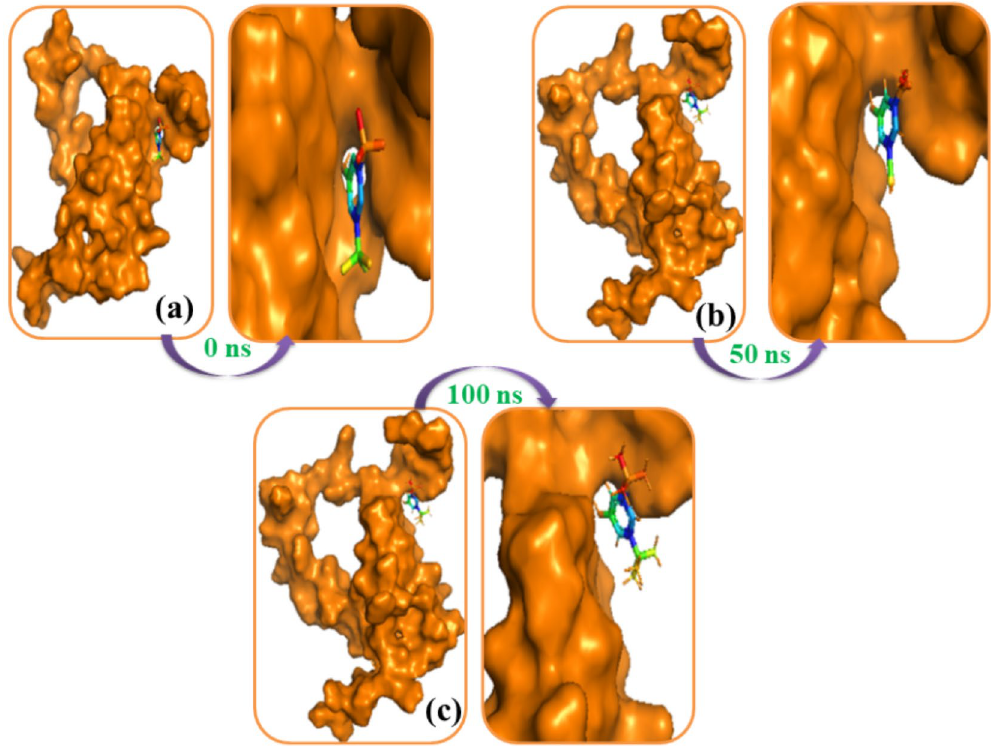
Figure 12. The simulation snapshots of MYB and 3,5-ditert-butylphenol complexes acquired from the trajectories, where rigid profiles of the ligand–protein complex were observed in the same binding pockets. The snapshots (a–c) were taken after 0, 50, and 100 ns intervals, respectively.